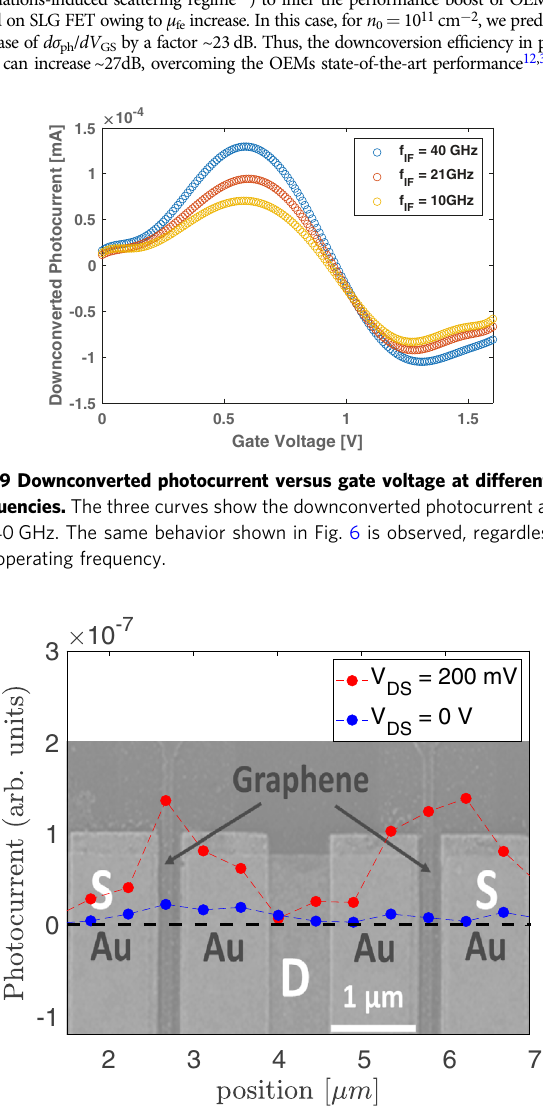
Fig. 10 Photoresponse as a function of laser spot position. The red and blue curves show the measured photoresponse as a function of laser spot position along the black dashed cut line, at 200 mV and 0 V,